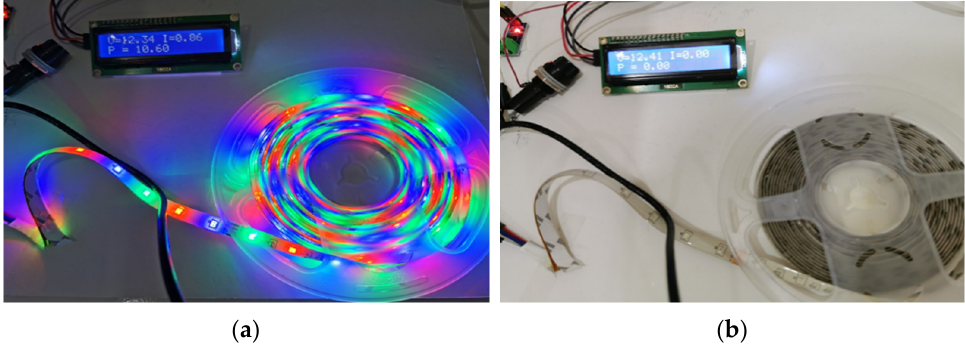
Figure 9. Measured data. ( a ) Relay is deactivated and ( b ) relay is activated.